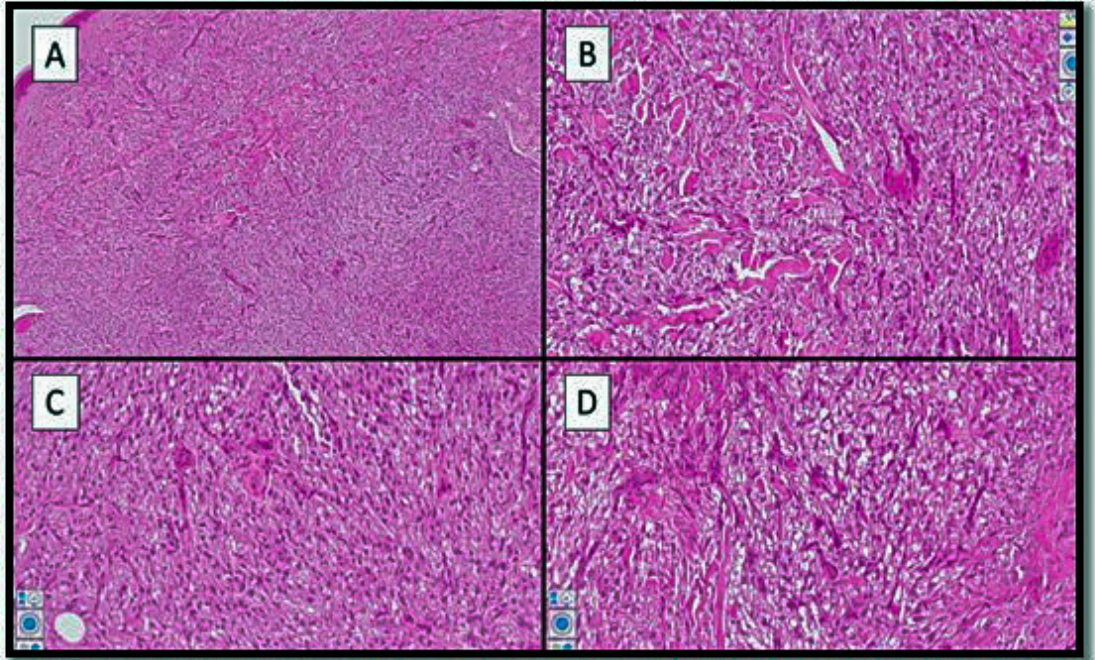
Figure 2. ( A , B ) The tumour was dermal-based, with a clear cell appearance and a chatacteris- tic trabecular pattern in which the tumour cells were arranged around numerous vessels ( C , D ) (hematoxylin–eosin, original magnification: 5 × , 10 × , 20 × , and 40 ×